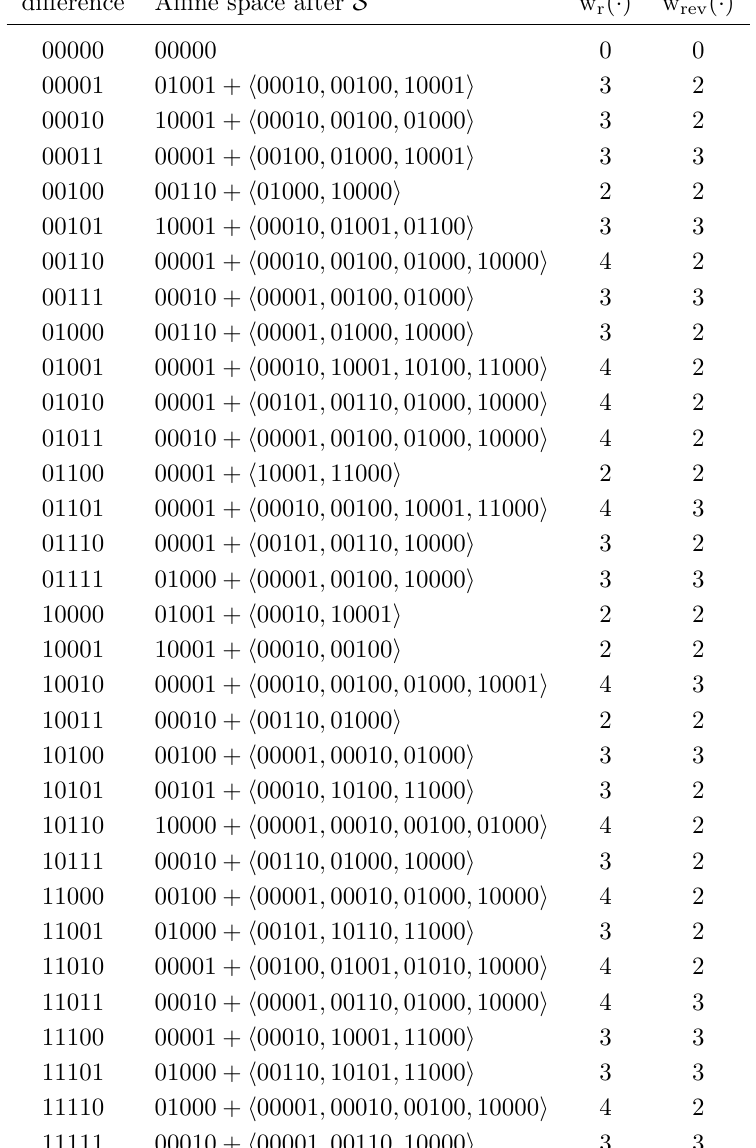
Table 7: Space of compatible differences at the output of p S , restriction weight, and minimum reverse weight for all possible column